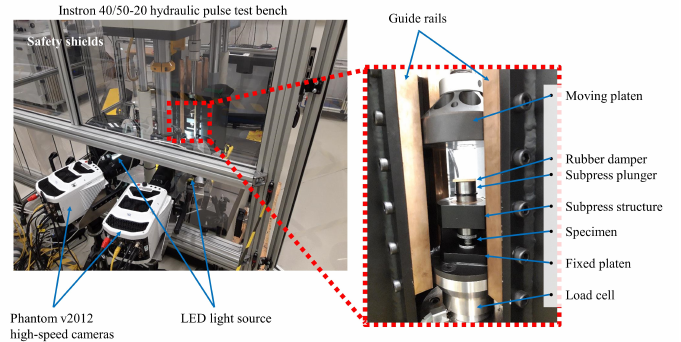
Figure 1. High speed compression setup based on the Instron 40/50-20 hydraulic pulse test bench accompanied with the high-speed cameras, lighting and guide rails.